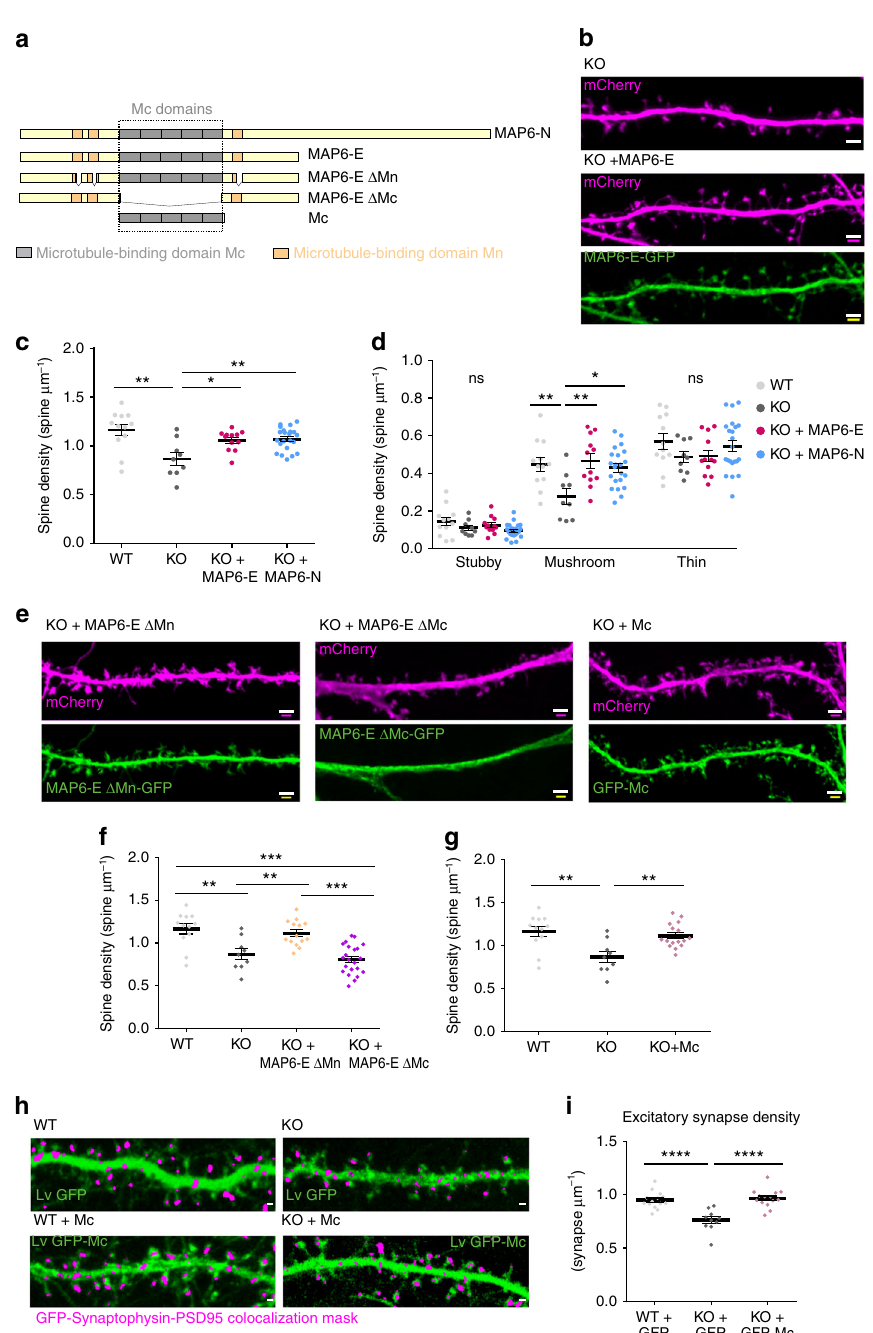
no longer signi fi cantly different from the density of 1.16 ± 0.06 spines/µm, observed for WT neurons (Fig. 2b, c). Analysis of spine morphology indicated that both MAP6-E-GFP and MAP6- N-GFP restored a normal density of mushroom-like spines in MAP6 KO neurons (Fig. 2d). We then examined the ability of MAP6-E mutants devoid of microtubule-binding sequence modules to correct spine density defects. Figure 2a depicts the two types of MAP6 microtubule-binding modules, the Mn modules (orange) and the Mc modules in the central domain (grey). When transfected in MAP6 KO neurons, MAP6-E lacking Mn